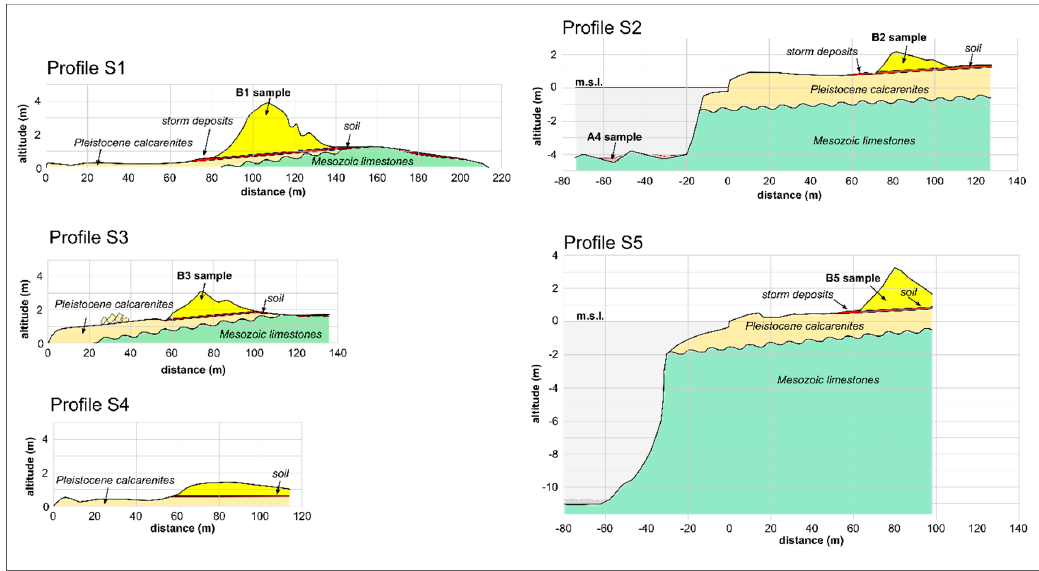
Figure 7. Geomorphological profiles carried out at five sites along the studied coast (location in Figure 5). Horizontal and vertical scales are the same for all profiles. The yellow area marks out the sand ridge deposits.